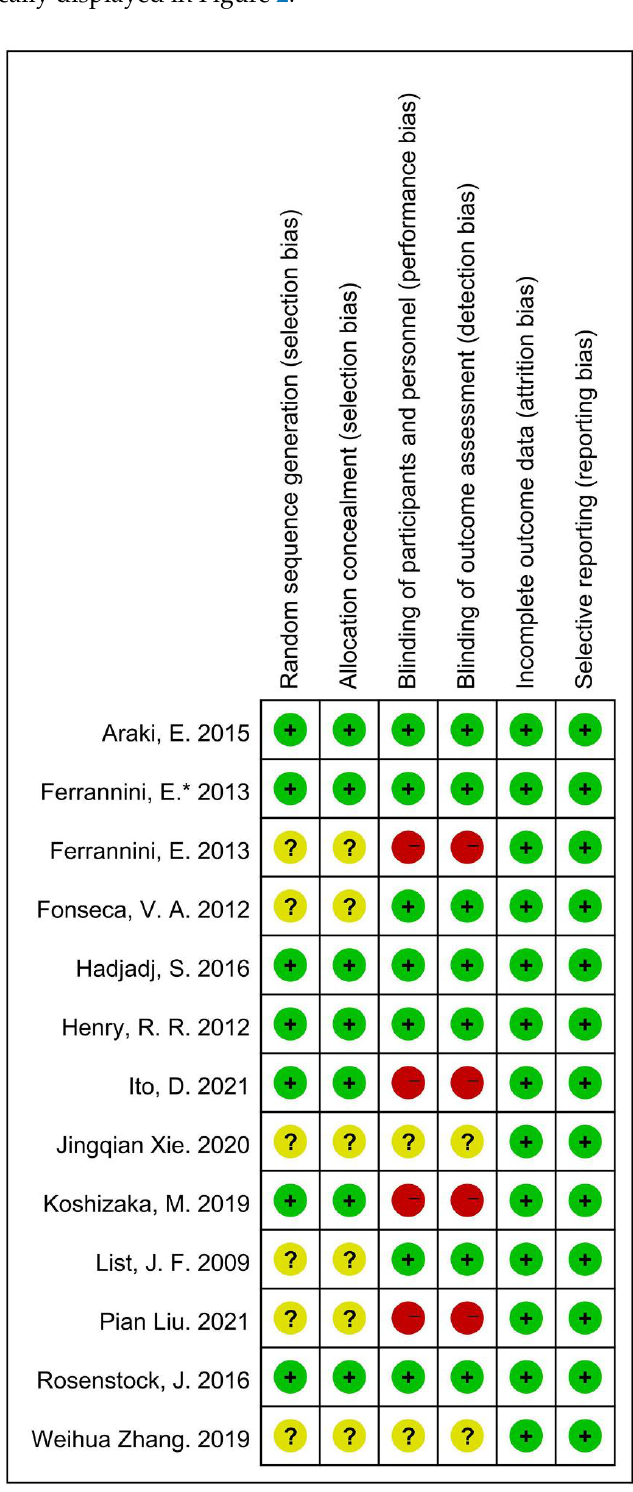
Figure 2. Figure for methodological quality of included trials [20–32]. Green symbol: low risk of bias; Figure 2 . Figure for methodological quality of included trials [20 – 32]. Green symbol: low risk of bias; Yellow symbol: unclear risk of bias; Red symbol: high risk of bias. Yellow symbol: unclear risk of bias; Red symbol: high risk of